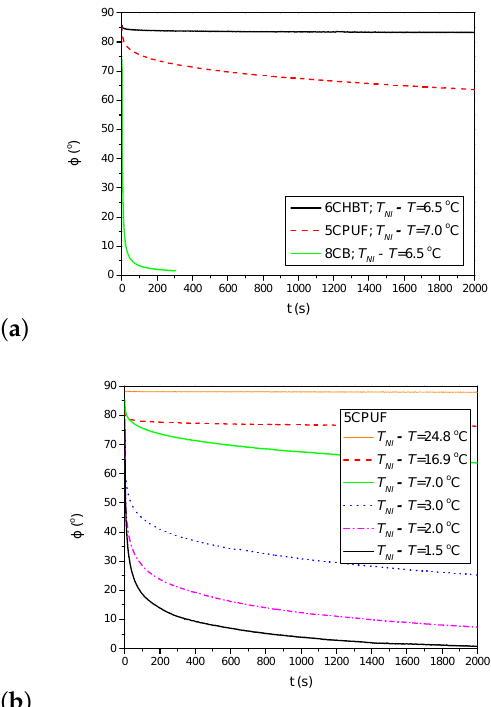
Figure 6. ( a ) Back-relaxation of the azimuthal photoalignment angle, ϕ for 6CHBT, 5CPUF and 8CB at relative temperatures T NI − T indicated in the legend. ( b ) Temperature dependence of the back-relaxation dynamics in the 5CPUF